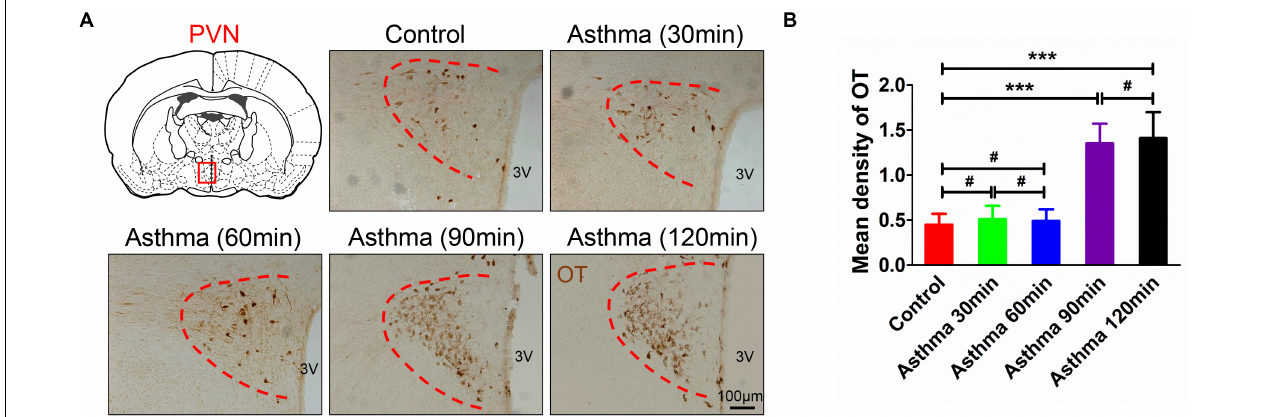
FIGURE 3 | (A) OT immunoreactive substance in PVN in asthma and control rats. (B) Mean density of OT immunoreactive substance in PVN in control and asthma (30, 60, 90, and 120 min) rats. The OT immunoreactive substance was brown staining, and OT expressions increased and peaked in the 90 and 120 min.